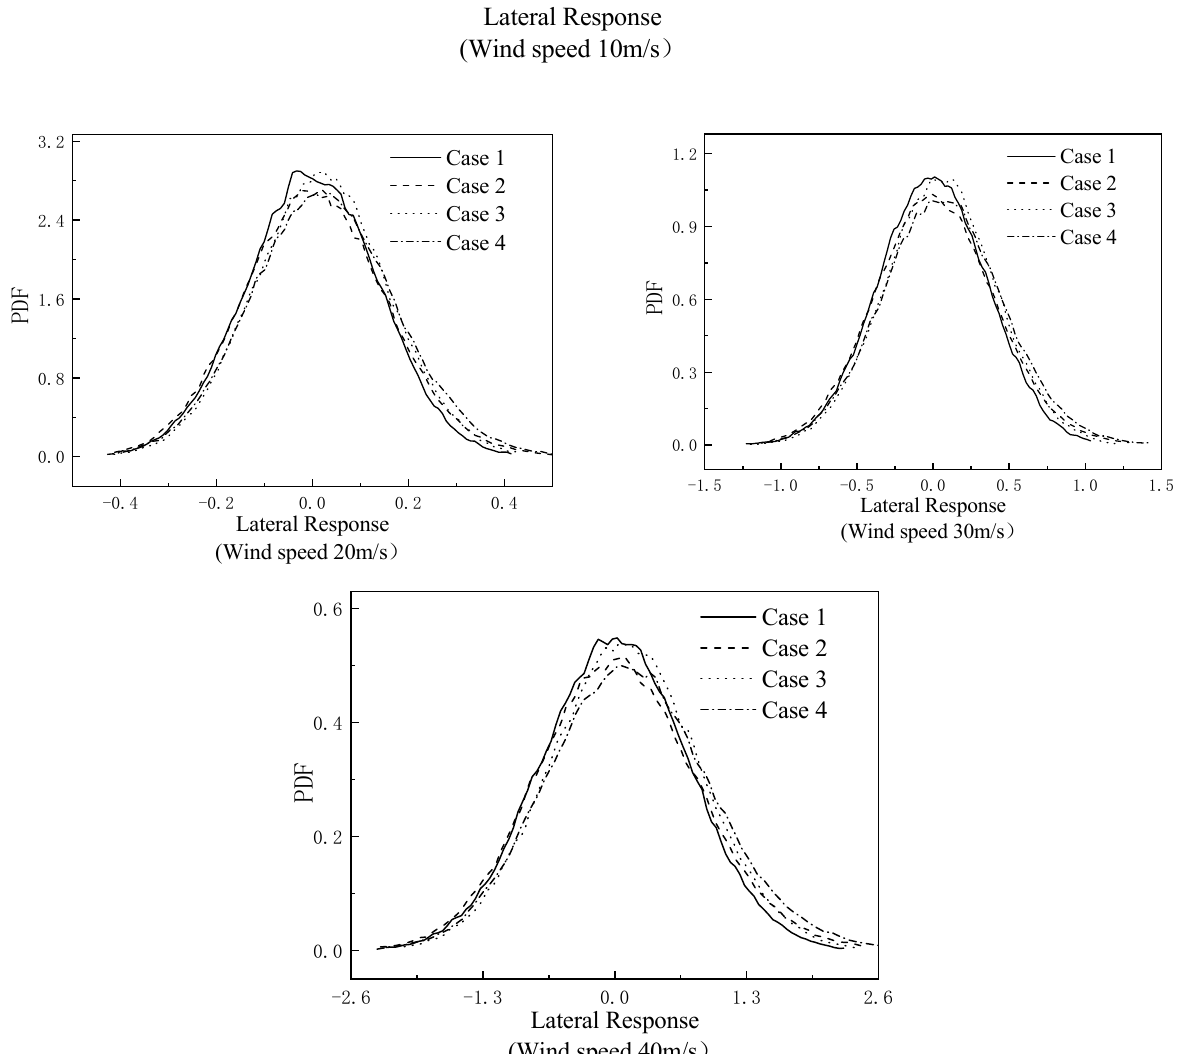
Figure 5. The PDF of the lateral stochastic responses of the bridge deck.